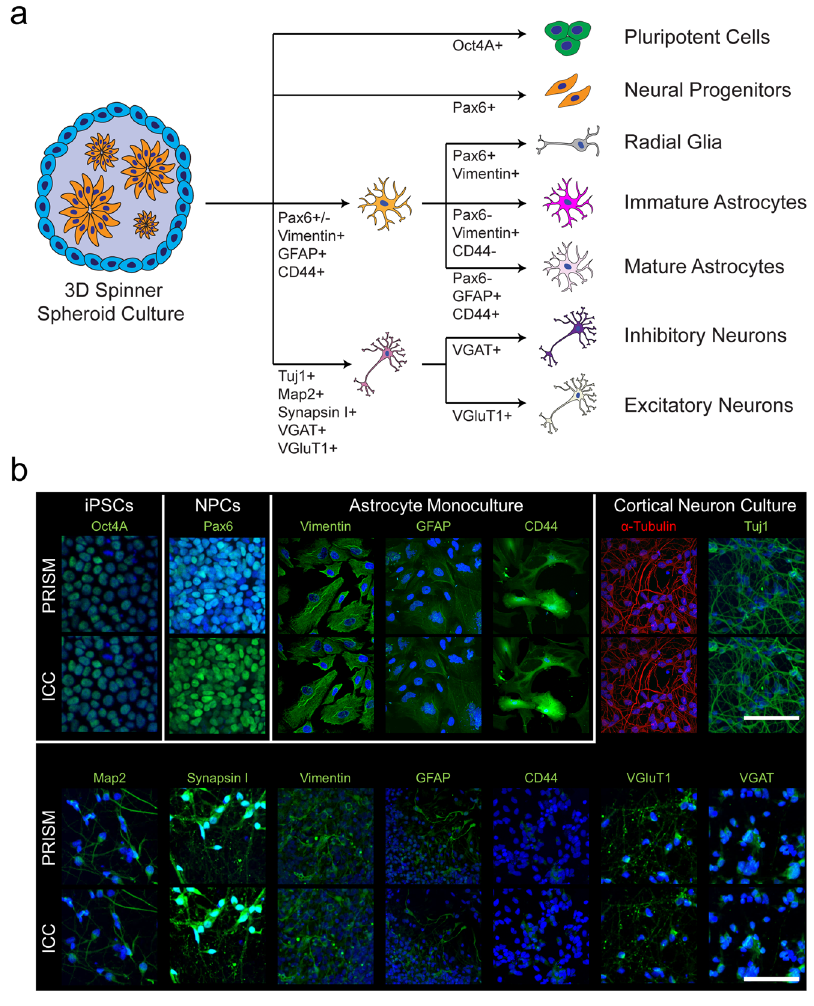
Fig. 2 Breakdown of cell populations present in iPSC-derived neural cultures and validation staining of marker panel targets used in the in-depth characterization. A schematic ( a ) of the different cell types in a typical cortical culture that can be tracked via PRISM. The fl ow chart illustrates a representative readout of the breakdown of cell populations in cortical cultures. b ICC versus PRISM images of stem cell derived day 85 cortical neurons to demonstrate staining of the markers used to characterize neural cultures. The Oct4A marker was imaged in the undifferentiated pluripotent state cell culture (iPCS), and the PAX6 marker was imaged in day 14 neural progenitor state cell culture (NPCs) for validation purposes. Scale bars are 100